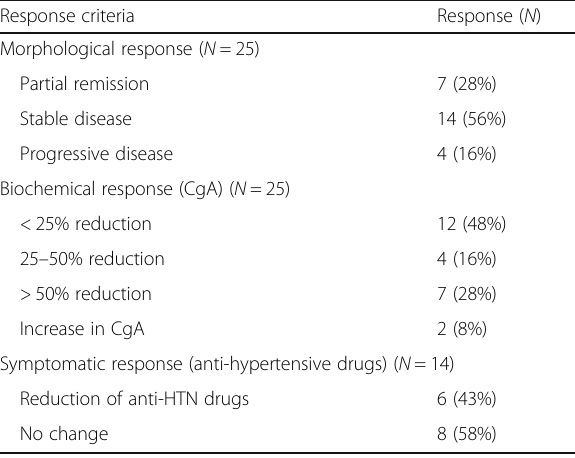
Table 2 Morphological, biochemical, and